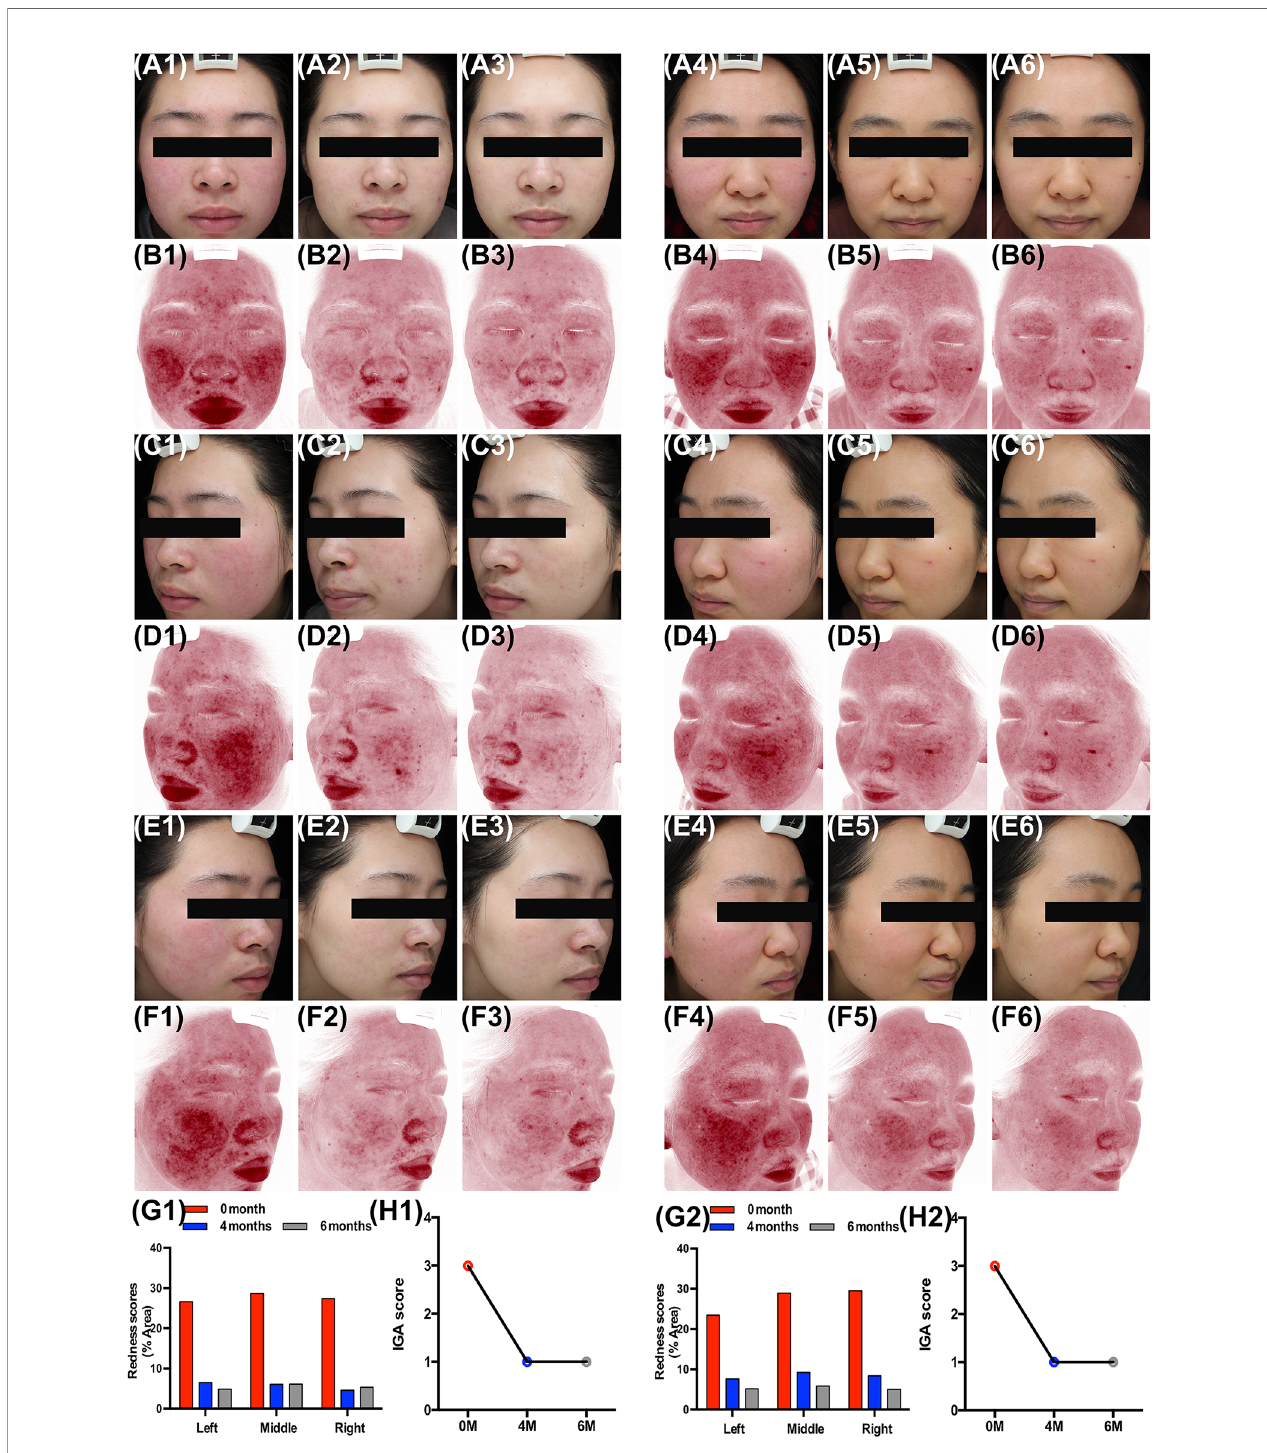
FIGURE 6 | Oral carvedilol effectively alleviates rosacea. Patient 1: Clinical manifestation and red area images as analyzed by VISIA before the treatment ( A1 , C1 , E1 , and B1 , D1 , F1 , respectively), at the four-month follow-up ( A2 , C2 , E2 , and B2 , D2 , F2 , respectively), and at the six-month follow-up ( A3 , C3 , E3 , and B3 , D3 , F3 , respectively). ( G1 ) Before and six months after treatment. Image J was used to determine the percentage of redness in VISIA images. ( H1 ) Investigator Global Assessment (IGA) score before and six months after treatment. Patient 2: Clinical manifestation and red area images as analyzed by VISIA before the treatment ( A4 , C4 , E4 , and B4 , D4 , F4 , respectively), at the four-month follow-up ( A5 , C5 , E5 , and B5 , D5 , F5 , respectively), and at the six-month follow-up ( A6 , C6 , E6 , and B6 , D6 , F6 , respectively). ( G2 ) Before and six months after treatment. Image J was used to determine the percentage of redness in VISIA images. ( H2 ) IGA score before and six months after